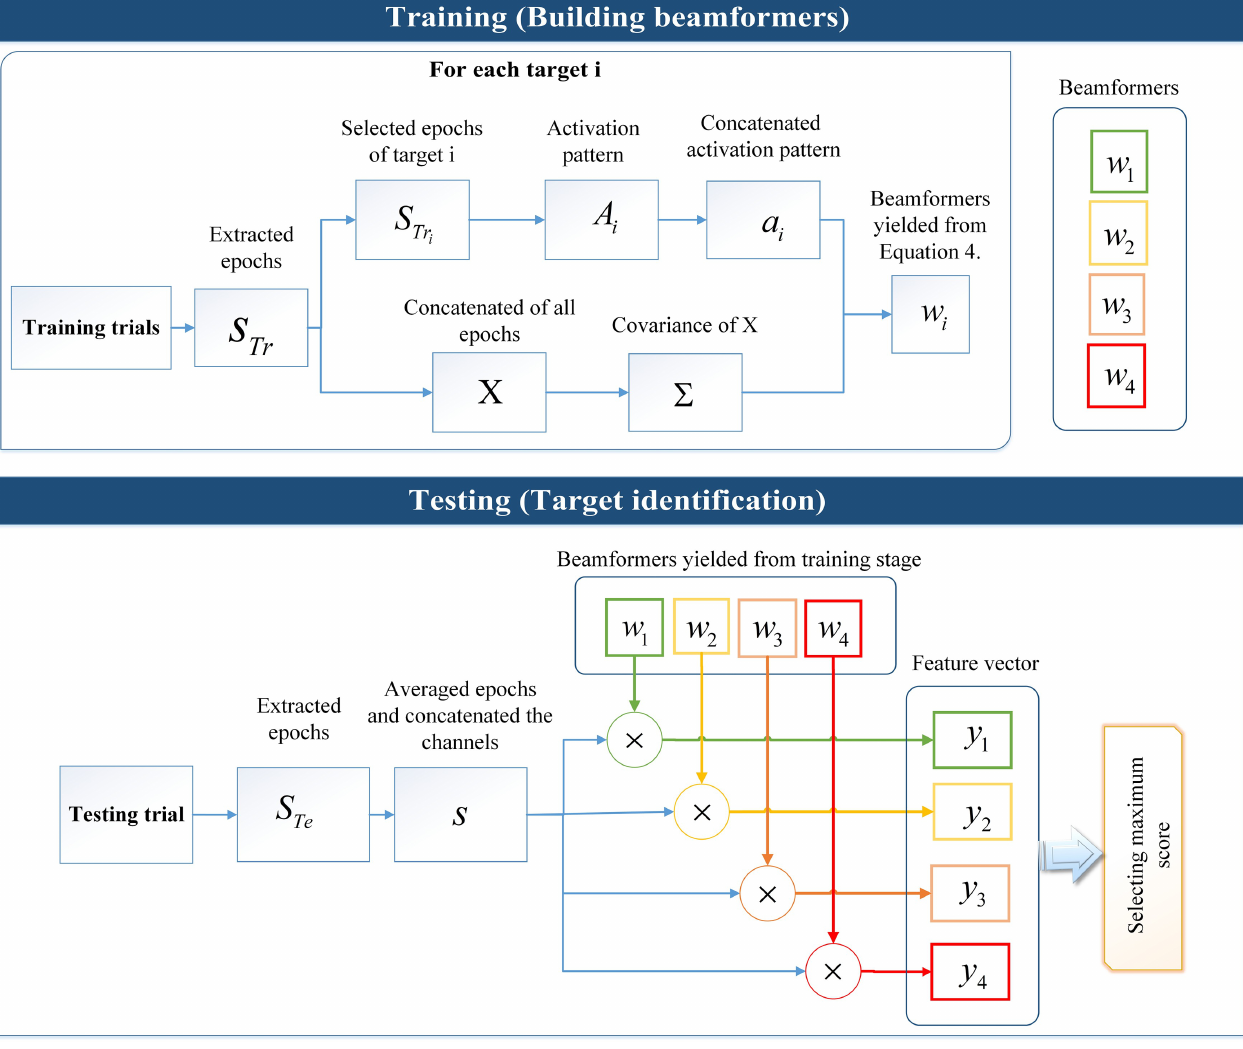
Fig 11. Schematic of representation of using STB for building beamformers and target identification. Building beamformers included extraction of epochs for all the targets and generation of the activation patterns for each target and in parallel calculation of covariance matrix of concatenated epochs. The beamformers were calculated from Eq 4. The target identification included multiplying the beamformers with concatenated channels of averaged epochs in testing trials for the generation of feature vector and selecting the maximum score.